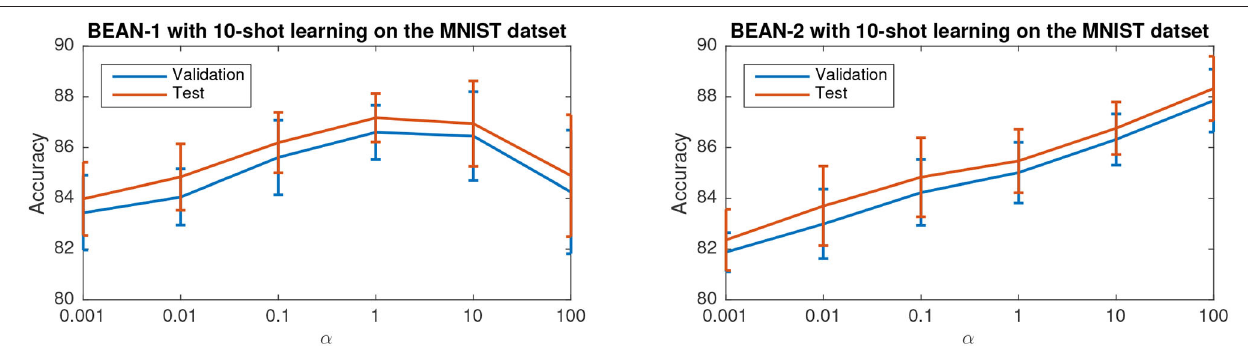
FIGURE 7 | Parameter sensitivity study of BEAN regularization on 10-shot learning on the MNIST dataset. Each data point is centered by the mean value and the error bar measures the standard deviation over 20 runs.